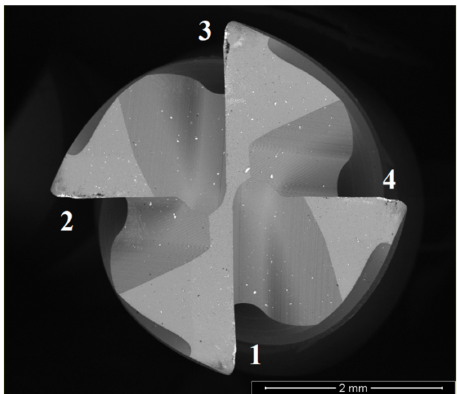
Figure 1. Reference for SEM analysis of the coated